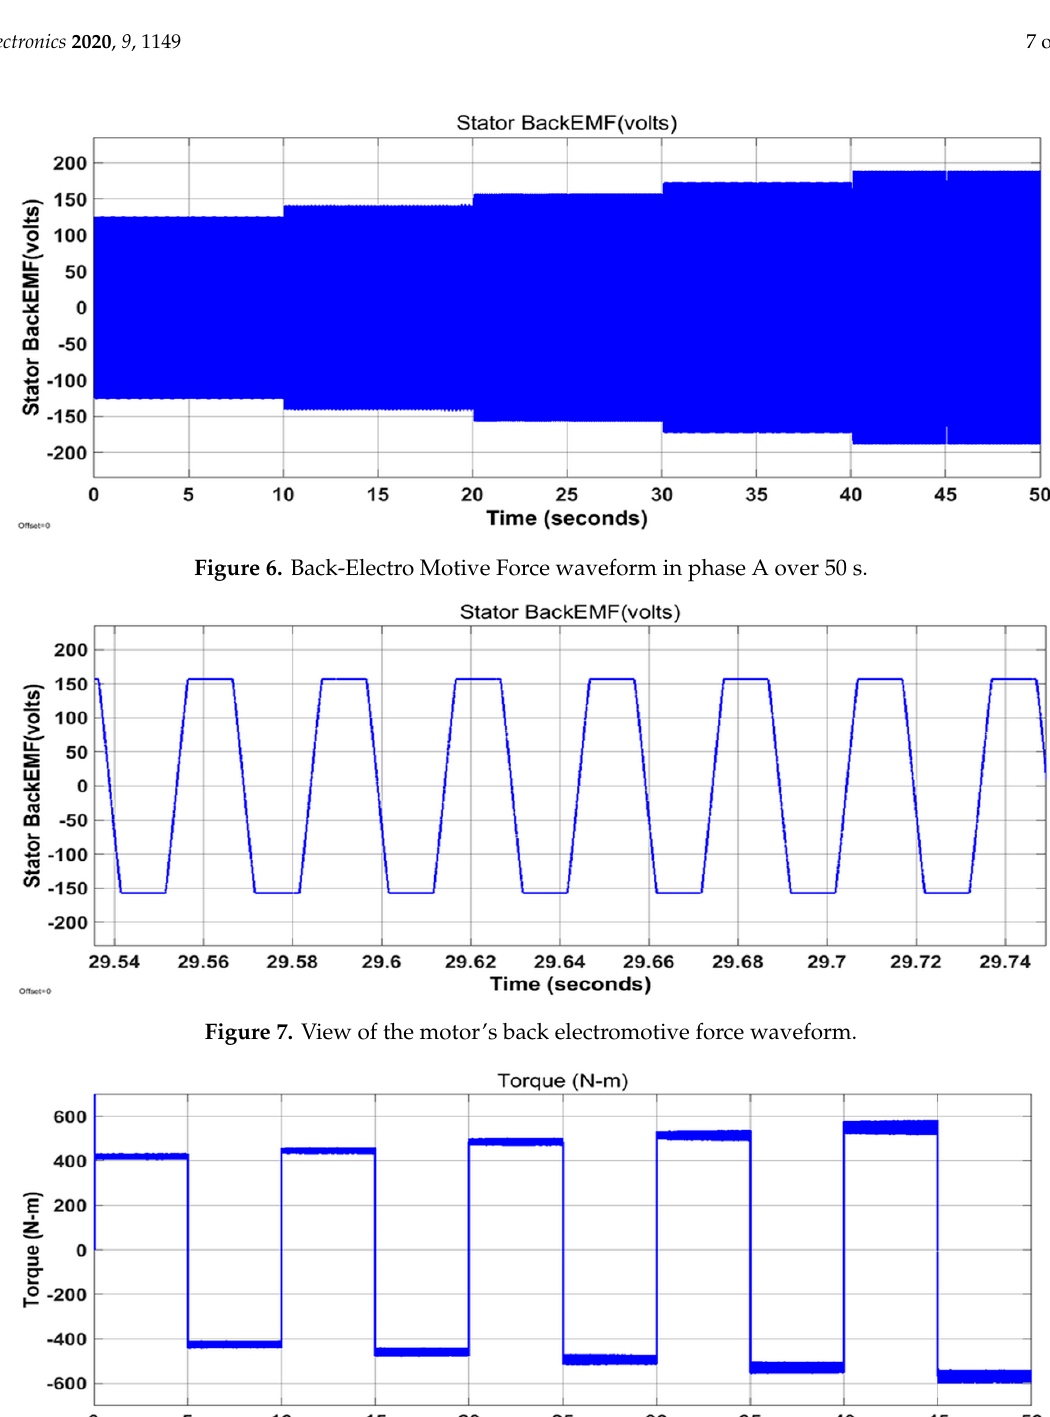
Figure 8. Torque over 50 s.